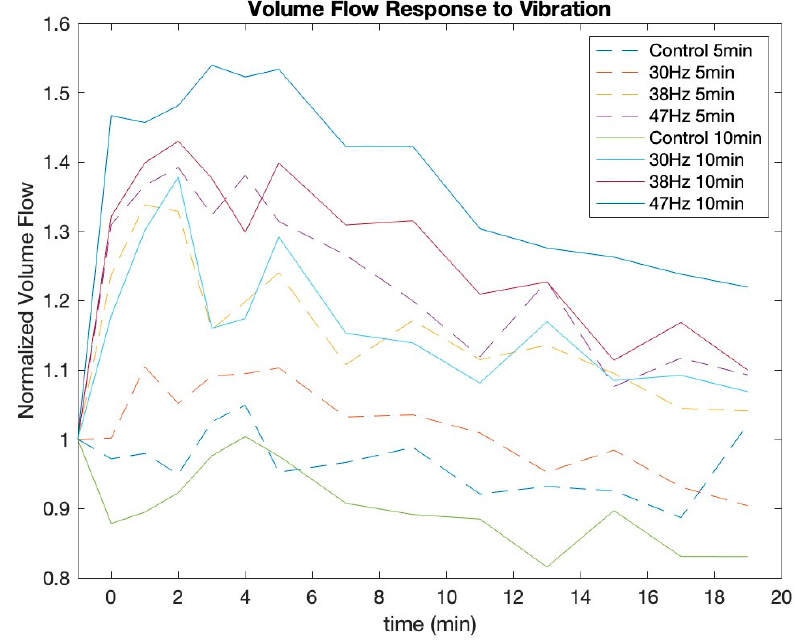
Figure 3. Normalized volume flow response to each vibration condition.